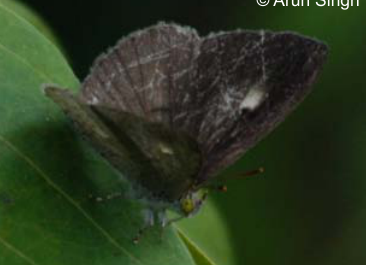
Image 24. Red-breast Jezebel Delias thysbe